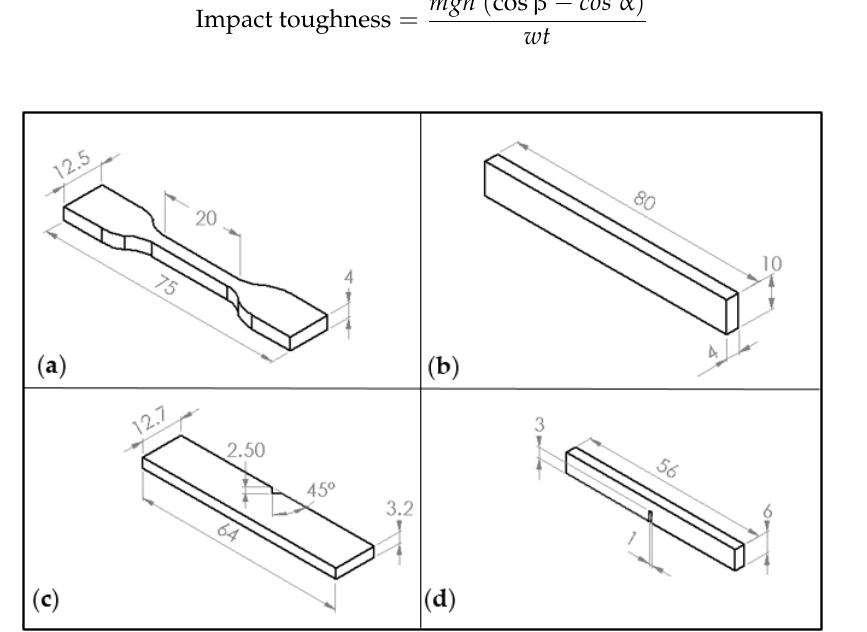
Figure 2. The illustration of specimens: ( a ) tensile; ( b ) flexural; ( c ) Charpy impact toughness; and ( d ) fracture toughness, K 1C .